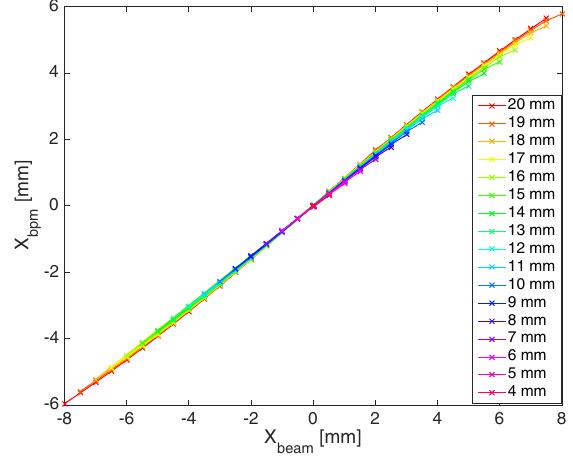
FIG. 10. Nonlinear relationship between X TCTPV.4R2.B2, depending on the beam offset and jaw gap (see legend).